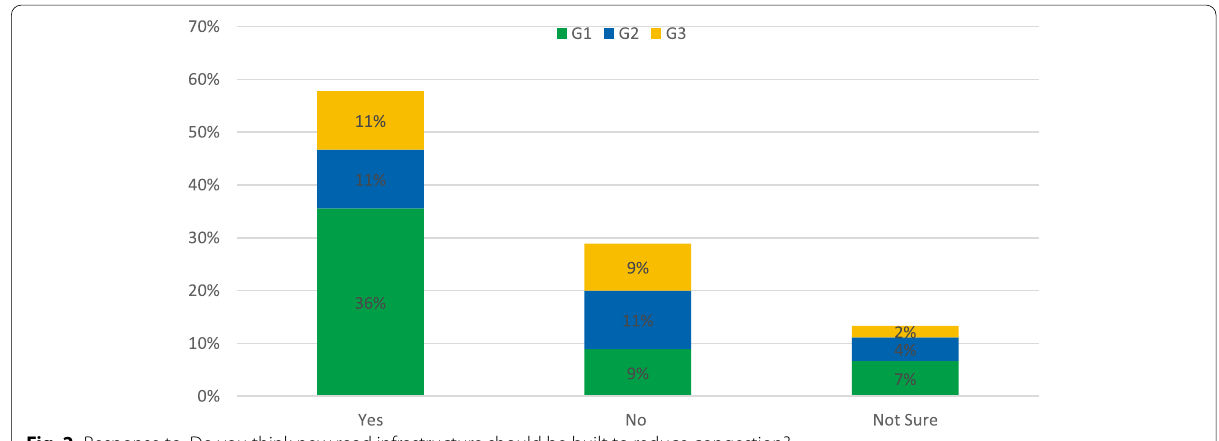
Fig. 2 Response to: Do you think new road infrastructure should be built to reduce